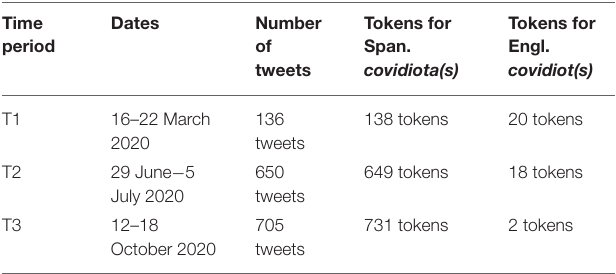
TABLE 1 | Number of results for covidiota in Spanish tweets, for the indicated time periods. Time Dates Number period